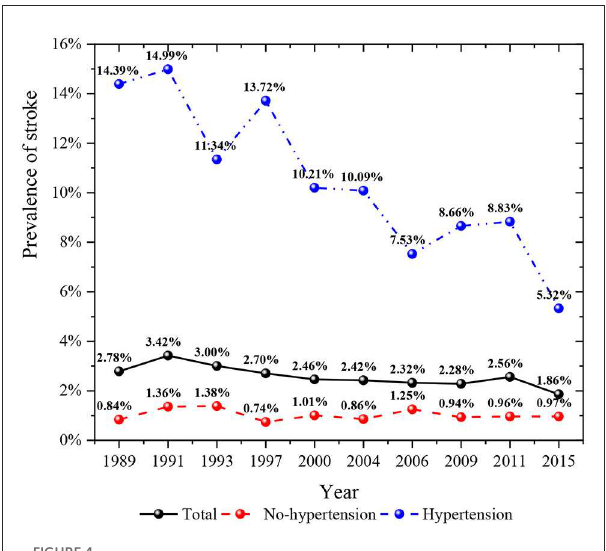
FIGURE6 Prevalence of stroke in different sleep duration groups in